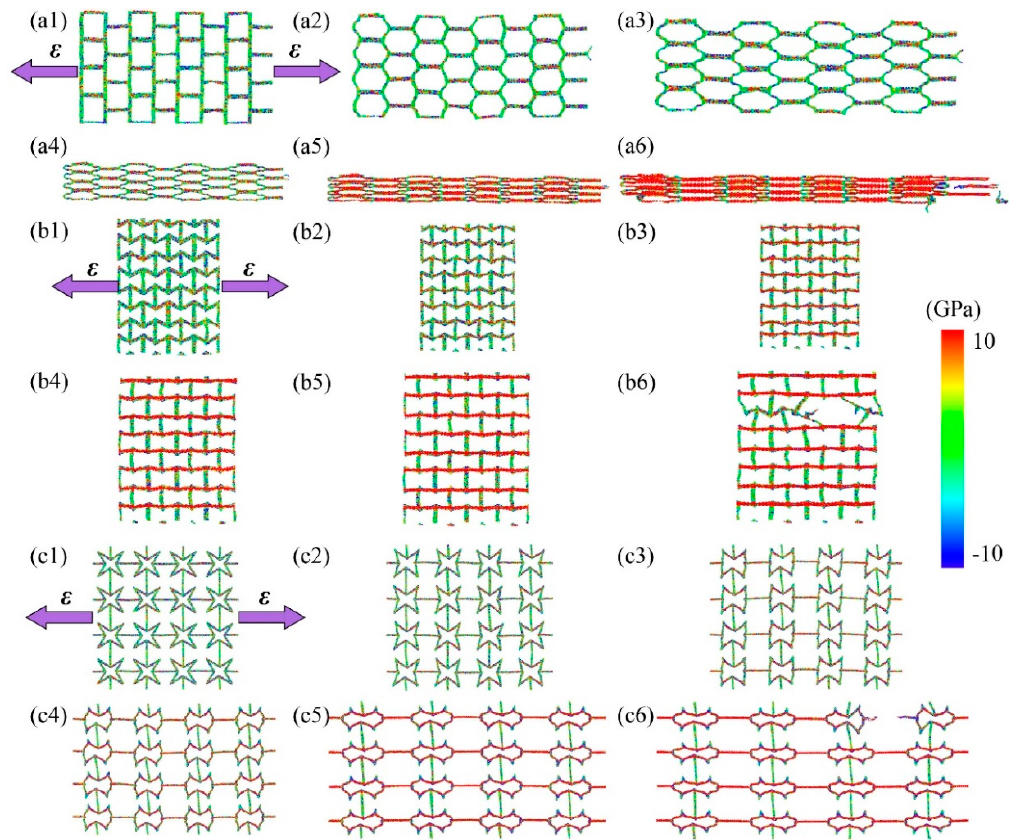
Figure 3. Configuration deformation and stress distribution of KGSs for system under tensile loading along the x-direction. ( a1 – a6 ) is process of the SKG’s model deformation and stress distribution under tensile loading. ( b1 – b6 ) is process of the RHH’s model deformation and stress distribution under tensile loading. ( c1 – c6 ) is process of the QSS’s model deformation and stress distribution under tensile loading.